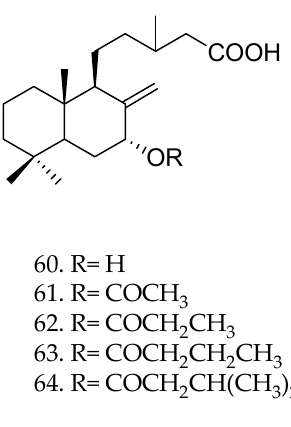
Figure 26. Chemical structures of diterpenes 60 – 64 [111].